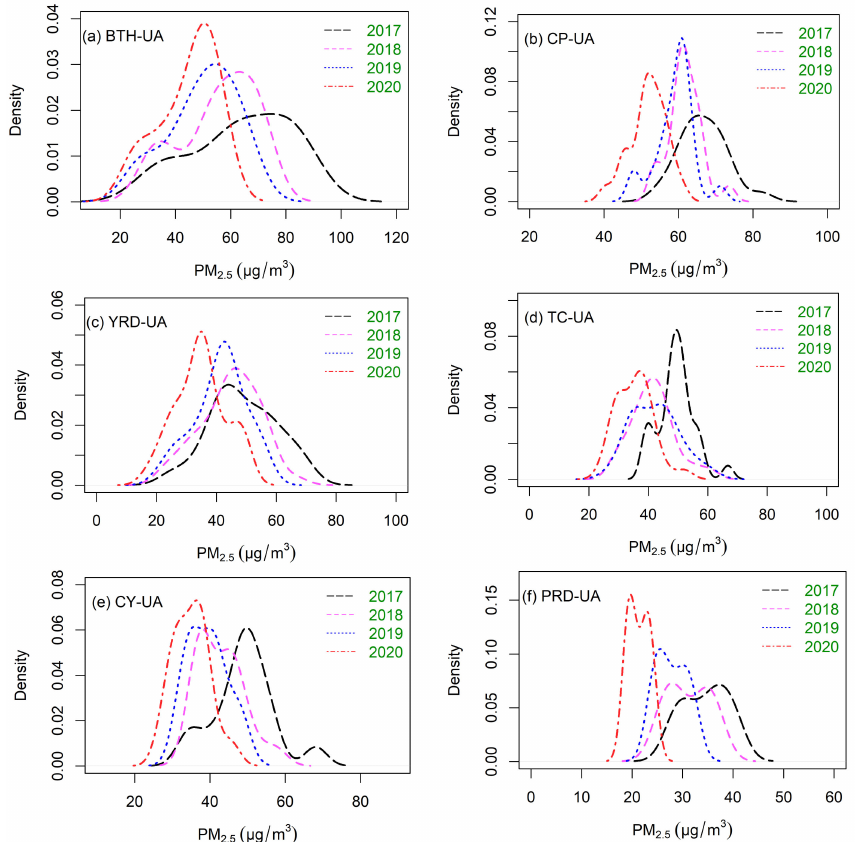
Figure 2. Kernel density estimates of yearly average PM 2.5 concentrations in six urban agglomerations of China. ( a ) BTH-UA, ( b ) CP-UA, ( c ) YRD-UA, ( d ) TC-UA, ( e ) CY-UA and ( f )